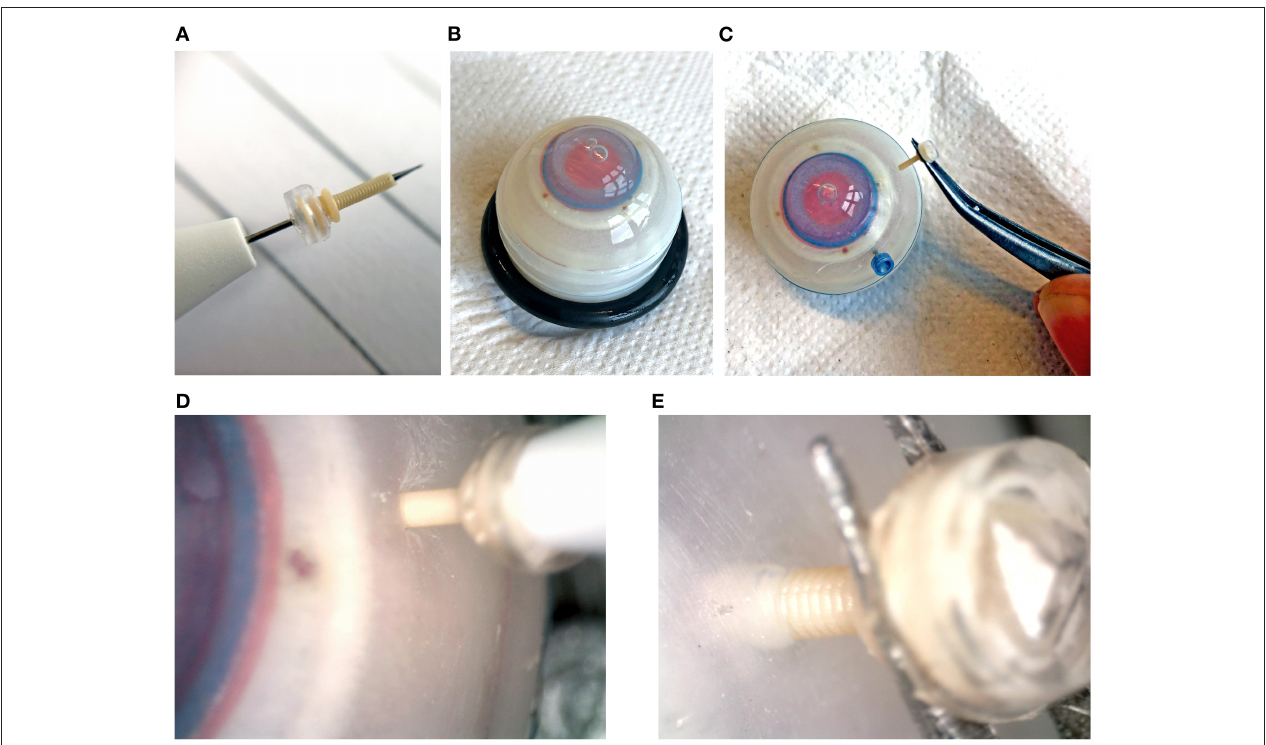
FIGURE 8 | Insertion tests into an artificial eye phantom. (A) Assembled trocar on a 27G commercial inserter knife. (B) Artificial eye for testing. (C) Removal of the 3D printed trocar from the eye, showing that it is still intact. (D) Magnification of the insertion of the 3D printed trocar, showing the deformation of the sclera. (E) Magnification of the removal of the 3D printed trocar.